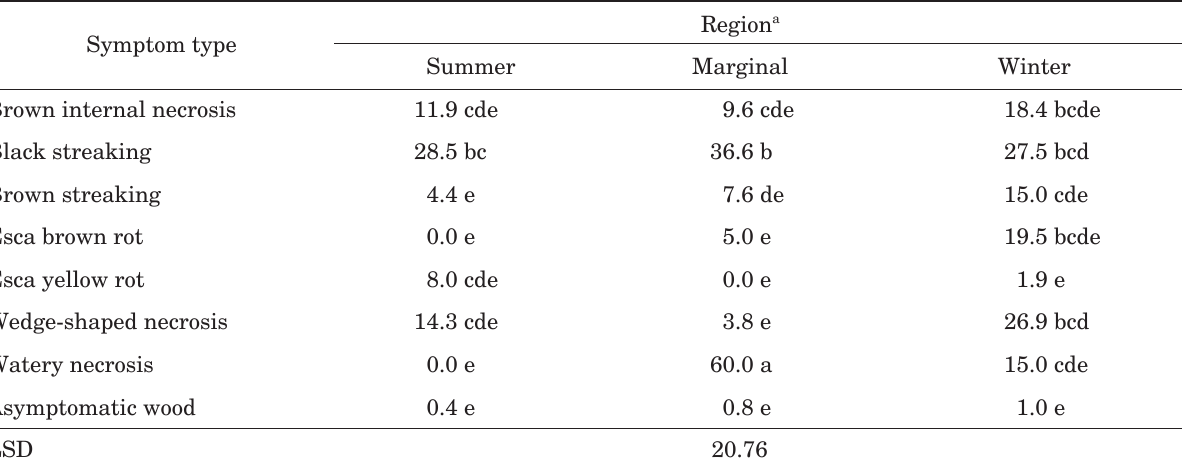
Table 4. Mean incidence of Phaeoacremonium spp. in isolates from vines displaying different symptoms in the sum- mer, marginal and winter rainfall regions of South Africa.